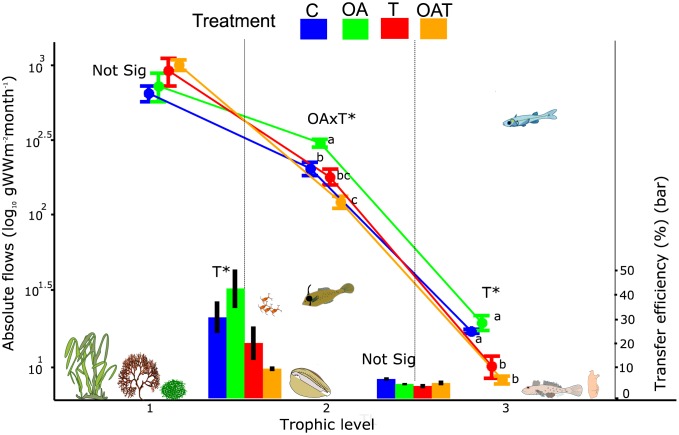
The effects of future climate on absolute flows and transfer efficiency between successive trophic levels of the mesocosm food web.Absolute flows, shown as line diagrams, refer to the total amount of energy that flows to higher trophic levels through consumption (log10 g Wet Weight/m2/month) aggregated by trophic level. The first trophic level shows flows originating from both the primary producers and detritus, which are transferred to the second and third trophic level through consumption by herbivores and carnivores, respectively. Transfer efficiency, presented as bar charts, refer to the ratio at which absolute flows are transferred from one trophic level to the next. Mean ± SE are based on n = 3 mesocosms. Significant effects (p < 0.05) within trophic levels are based on two-way ANOVAs (df = 1,8) and are indicated with asterisks. See S1 Table for statistical test outcomes. Means with different lower-case letters indicate significant differences among treatments based on posthoc tests corrected for false discovery rate and done separately for different trophic levels. The distribution of organisms within the mesocosms is reflected as their vertical position inside the graph (ranging from the bottom of the mesocosm to the surface of the water column). Species cliparts were obtained or modified from Openclipart (https://openclipart.org/). C, control; not sig, not significantly different; OA, elevated CO2; OAT, elevated CO2 and temperature; T, elevated temperature.